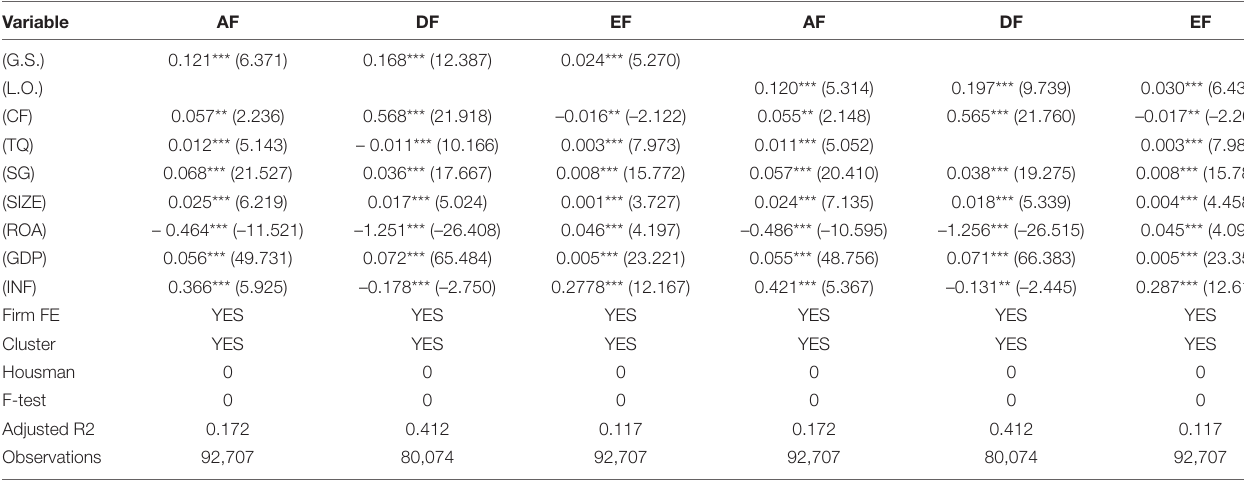
TABLE 8 | Robust checks: two alternate policy-related proxies.